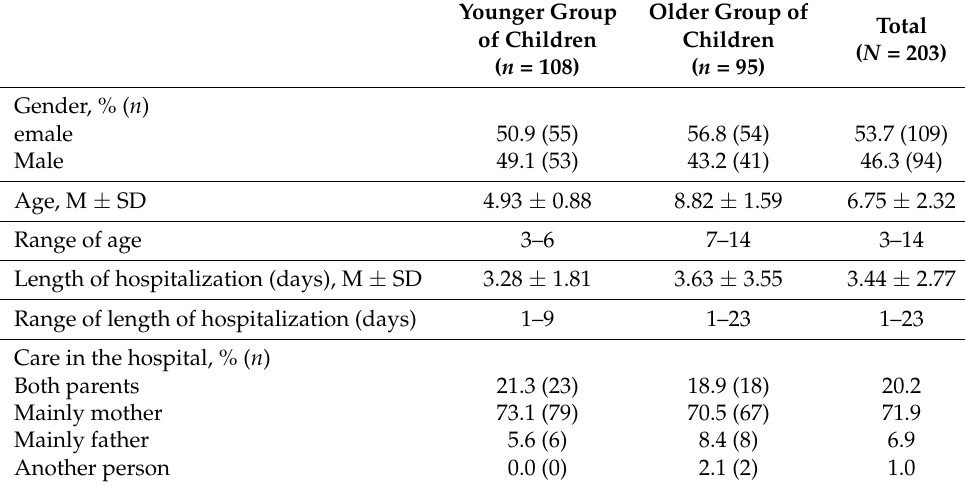
Table 2. Characteristic of children